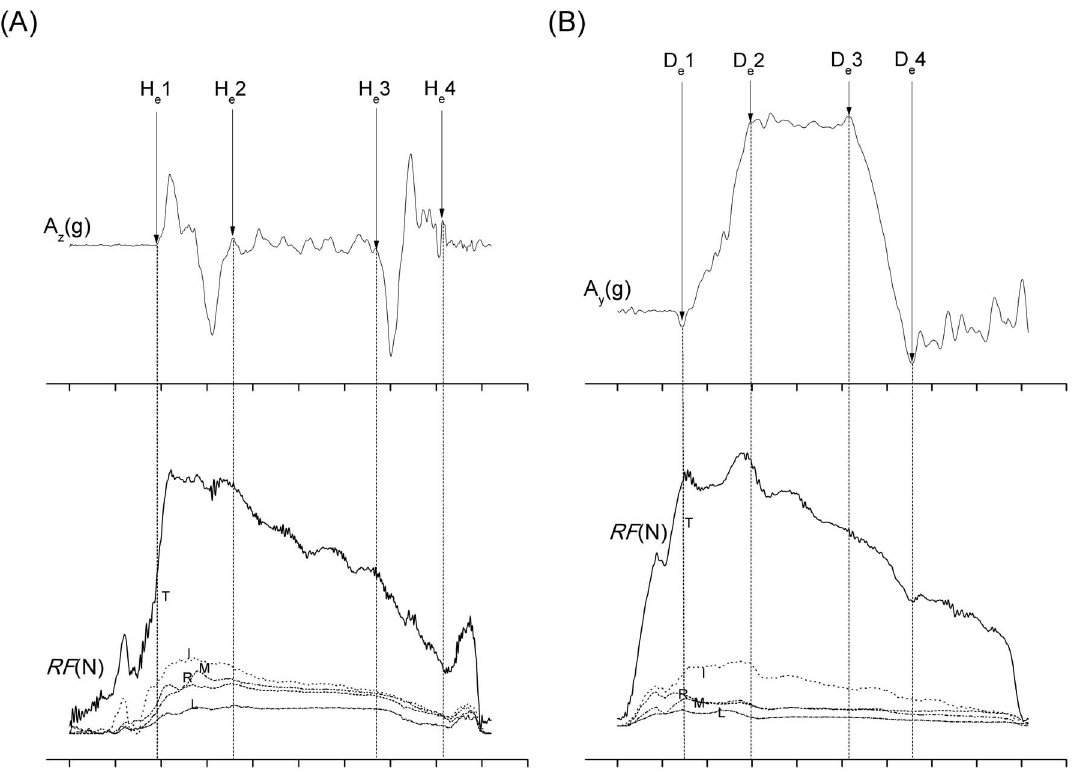
Figure 2. The determination of four movement events in each task. The events were found by the specific turning points of acceleration (A) along Z a axis during the holding task including H e 1 (the first turning point of the first positive peak of acceleration), H e 2 (the first point of the sustained plateau which follows a negative peak), H e 3 (the turning point at the end of plateau which is followed by a negative peak) and H e 4 (the final peak), and (B) along Y a axis by determining the four turning points (D e 1, D e 2, D e 3 and D e 4) of on trapezoid-shaped profile. Three phases were then defined in between sequential events in each